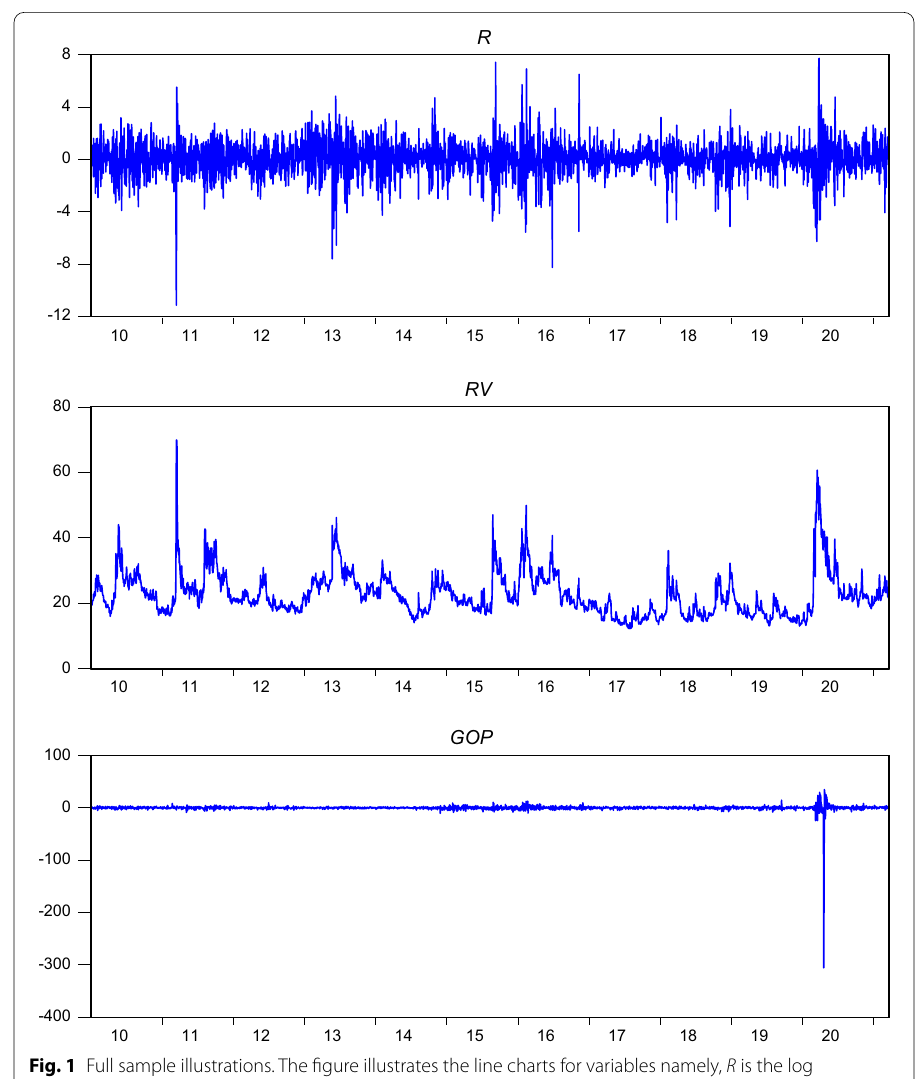
Fig. 1 Full sample illustrations. The figure illustrates the line charts for variables namely, R is the log percentage return of the Nikkei price index; RV is the Nikkei stock average volatility index, finally GOP is the growth rate in the WTI spot price of